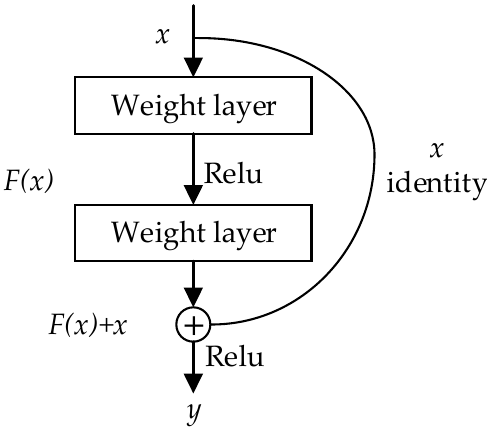
Figure 1. Residual learning: a building block.